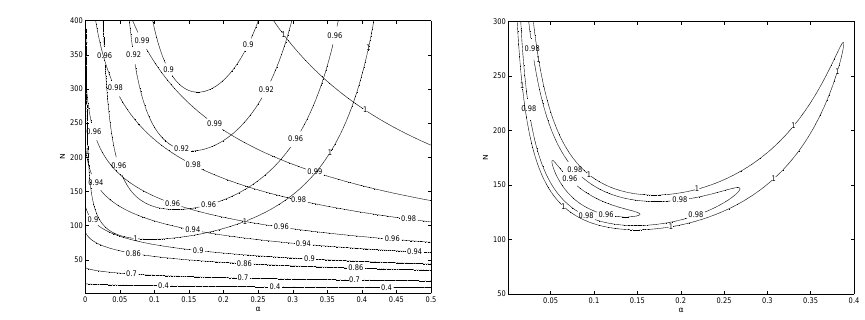
Figure 14. Contour plots of the objective function φ 1 ( α,N,m,r 0 ) given by (5.1) for r 0 = 0 . 1 , m = 6 and K = 100